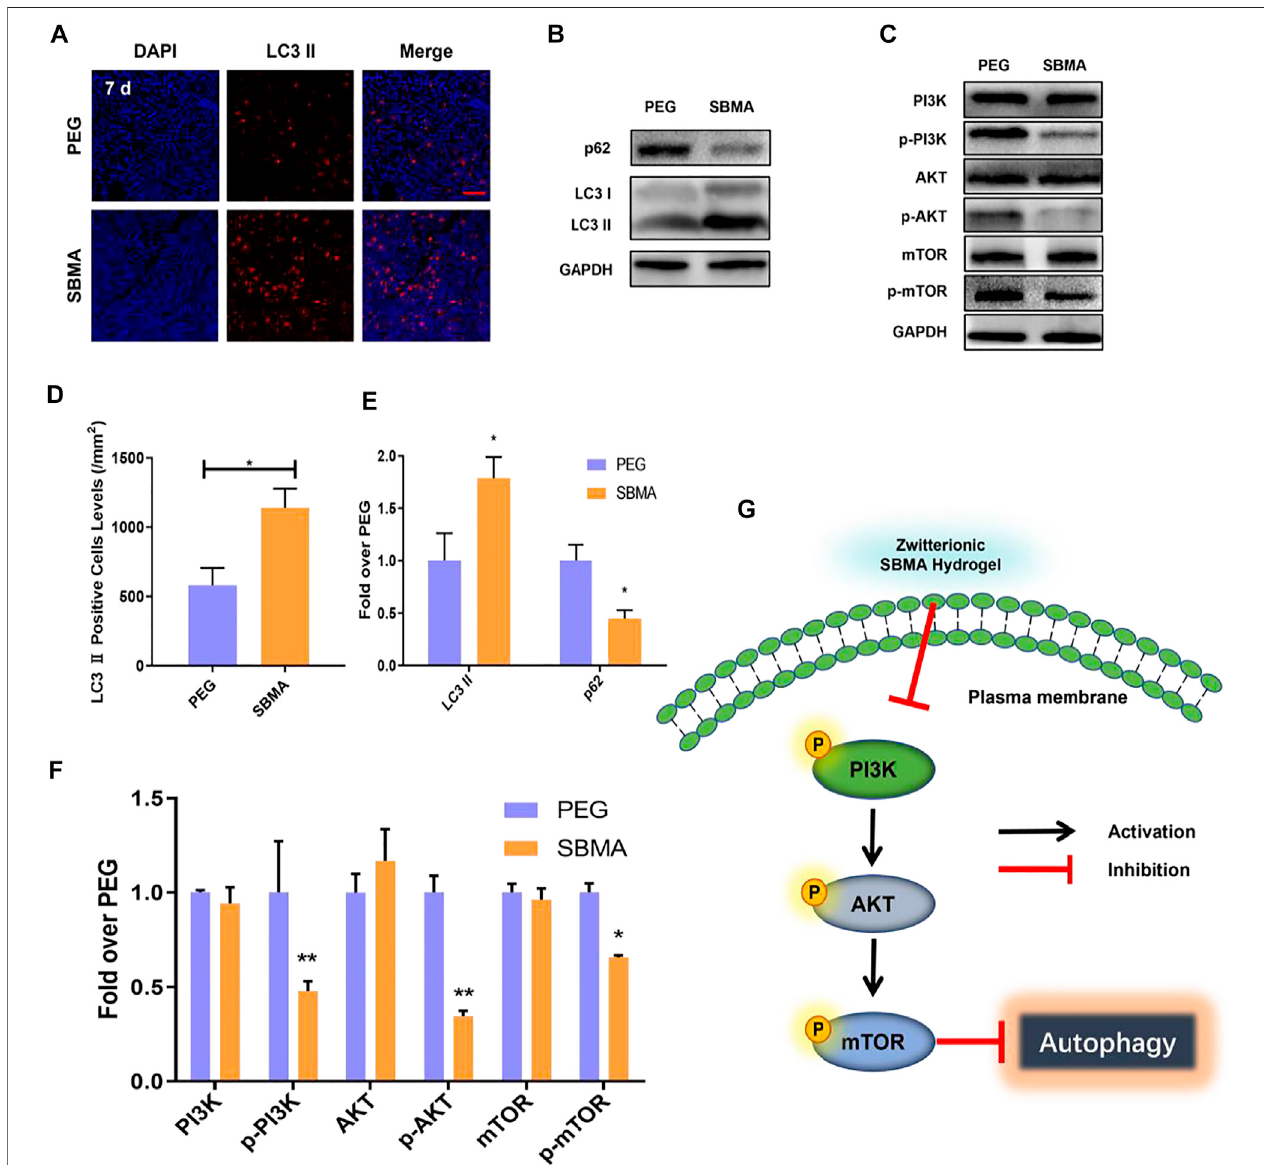
FIGURE6| In vivo autophagy investigation. (A) Immuno fl uorescent stainingofLC3 Ⅱ (red) for thetwogroups on day 7(scale bar (cid:1) 50 µm). (B – C) Western blotting for LC3 Ⅱ , P62, PI3K, p- PI3K, AKT, p-AKT, mTOR, and p-mTOR expressions in the pressure ulcer of the PEG and SBMA groups. The gels have been run under the sameexperimentalconditions,andcroppedblotsareusedhere. (D) ImmunohistochemicalresultswithLC3 Ⅱ levelsinwoundsonday7forthetwogroups. (E – F) Optical density values of LC3 Ⅱ , P62, PI3K, p- PI3K, AKT, p-AKT, mTOR, and p-mTOR were quanti fi ed and analyzed each group. (G) Scheme of zwitterionic SBMA hydrogel treatment inhibited thePI3K/Akt/mTORsignaling pathwayand upregulated autophagy.Signi fi cantdifferenceisindicatedas* p < 0.05,** p < 0.01,*** p < 0.001, and n (cid:1) 3.